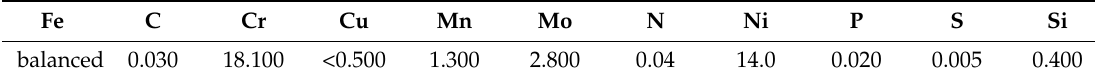
Table 1. Chemical composition (wt-%) of the used 316LVM (X2 CrNiMo 18-15-3/DIN EN 1.4441) wire (Ø 0.5 mm).